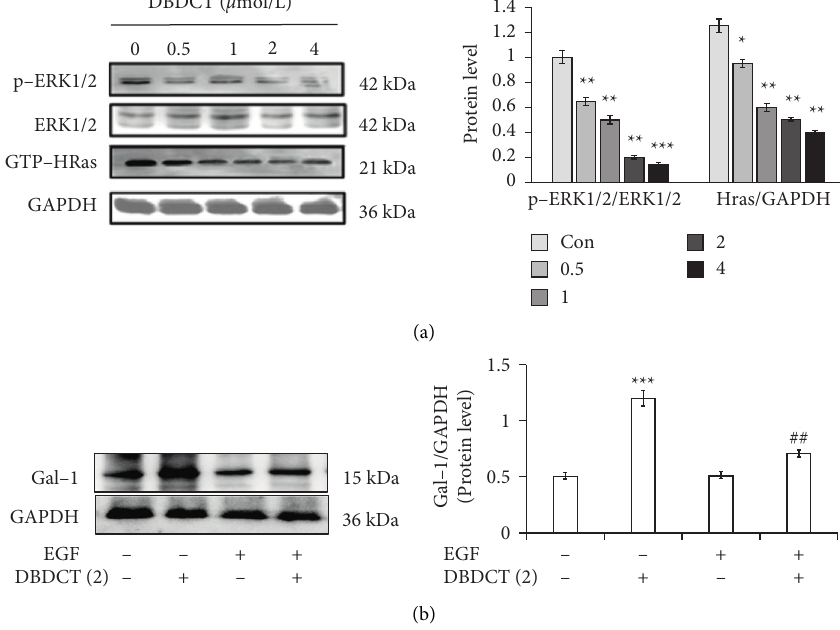
Figure 7: Effects of DBDCT on the expressions of p-ERK1/2, ERK1/2, and Ras with different concentrations for 24h and effects of EGF (ERK1/2 activator) on the expressions of Gal-1 induced by DBDCT in HL7702 cells. (a) Expressions of p-ERK1/2, ERK1/2, and Ras. (b) Effects of EGF (30 ng/mL) on the expressions of Gal-1. Each value represents the mean ± SD of three independent experiments. ∗ p < 0 . 05, ∗∗ p < 0 . 01, and ∗∗∗ p < 0 . 001, compared with the control. # p < 0 . 05 and ## p < 0 . 01, compared with the DBDCT